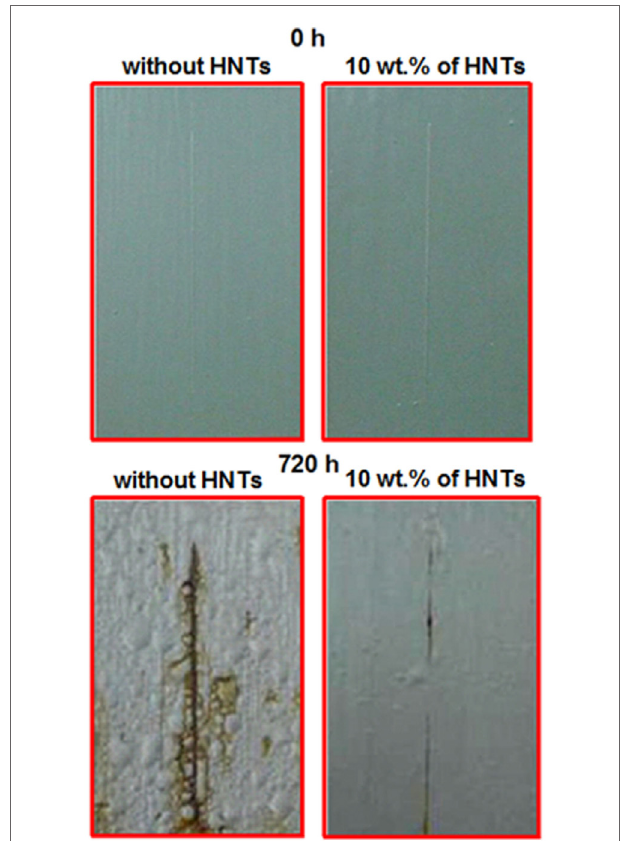
FigUre 11 | aspect of coated samples with two layers of alkyd primer containing 0 and 10 wt.% of halloysite nanotubes before and after 720 h of exposure in the salt spray chamber